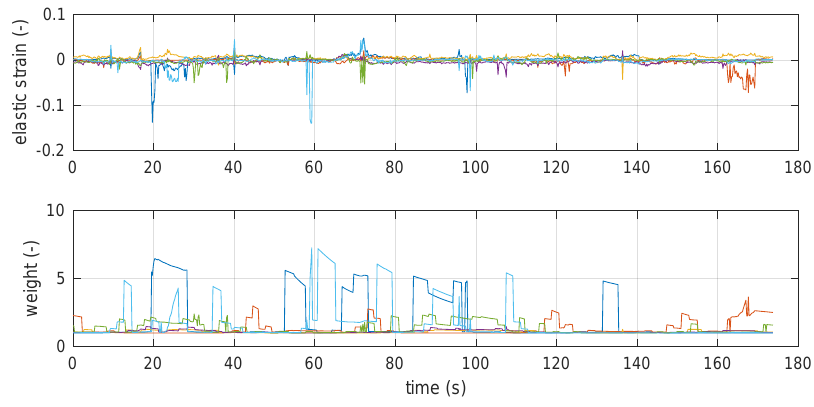
Figure 6. Top : Elastic strain associated to beacon 1–6, as calculated by the optimization algorithm, as a function of time along the test measurement of Figure 5 (during second-run). Bottom : Evolution of weights applied during the second-run.